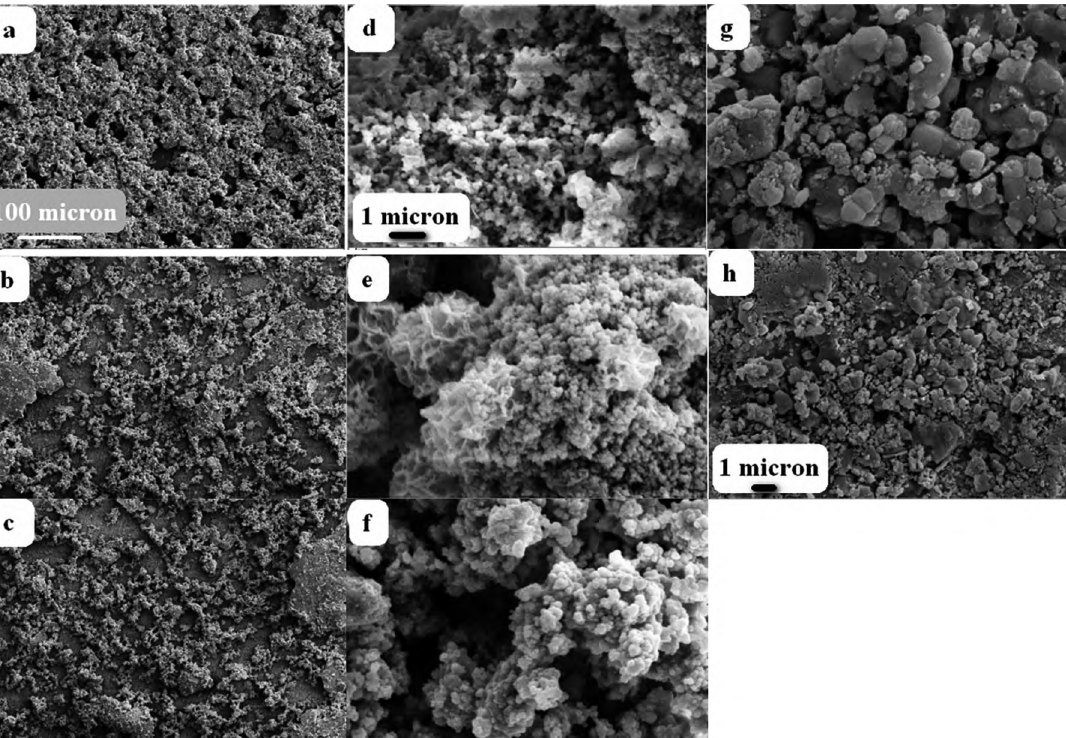
Figure 6. SEM Morphology of the precipitated layers on the surface of samples in α-NZF (a & d), β-NZF (b & e), γ-NZF (c & f) and the blank solution (g & h) after 44 h immersion.